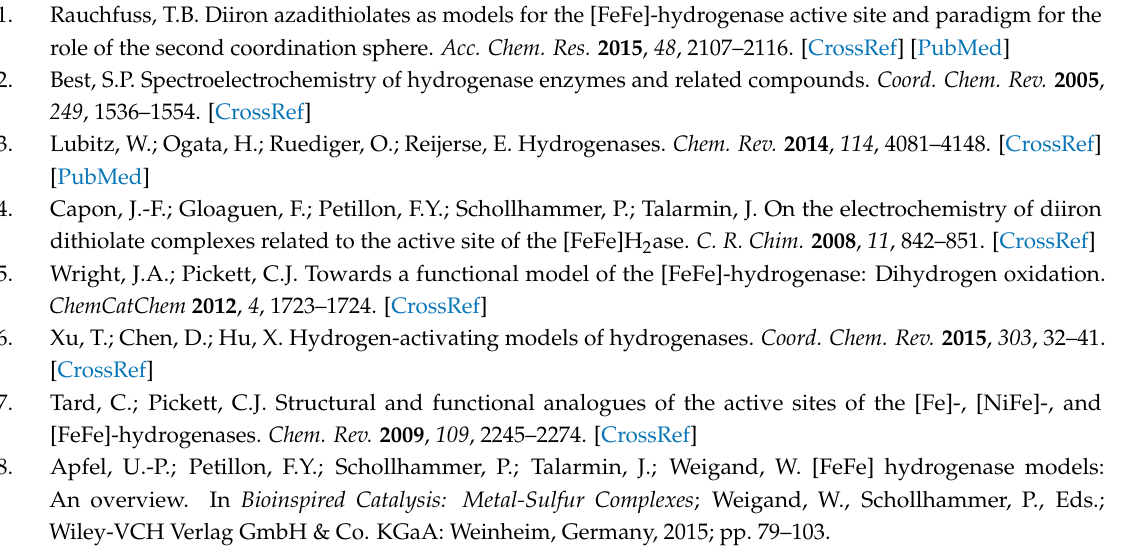
Figure S1 Cyclic voltammogram of (— —) nitrobenzene (2 mM) and (—) CH 3 C(CH 2 S) 2 CH 2 S(C 6 H 4 - p -NO 2 ) (2 mM) (0.2 M [NBu 4 ][BF 4 ] in acetonitrile, 0.1 V · s − 1 ). Figure S2. Cyclic voltammograms of the primary reduction processes of nitrobenzene (2 mM, 0.2 M [NBu 4 ][BF 4 ] in acetonitrile, 0.1 V · s − 1 ) in the absence and in the presence of acetic acid: 0 (—), 1 (— —), 5 (—), 15 (– - – -) and 30 equivalents (— - - —). Figure S3. Cyclic voltammogram of 2,6-lutidinium tetrafluoroborate (0.4 M, 0.2 M [NBu 4 ][BF 4 ] in acetonitrile, 0.1 V · s − 1 ). Figure S4. IR-SEC single beam spectra recorded during (top) reduction and (bottom) re-oxidation of I-bzNO 2 in CH 2 Cl 2 (2 mM, 0.2 M TBAPF 6 ). For this, and subsequent, figures the initial spectrum of each block is shown in green and the final spectrum in blue. Figure S5. IR-SEC spectra recorded during (a) the reduction and (b) re-oxidation of I-bzNO 2 in the presence of HLut + . Table S1. EasySpin EPR simulation parameters for [ I-bzNO 2 ] − . Table S2. Determination of the free energy activation ( ∆ G ‡ ) parameter in CDCl 3 ; T c is the coalescence temperature; ∆ ν ab is determined from the slow limit spectra. Cif and checkcif